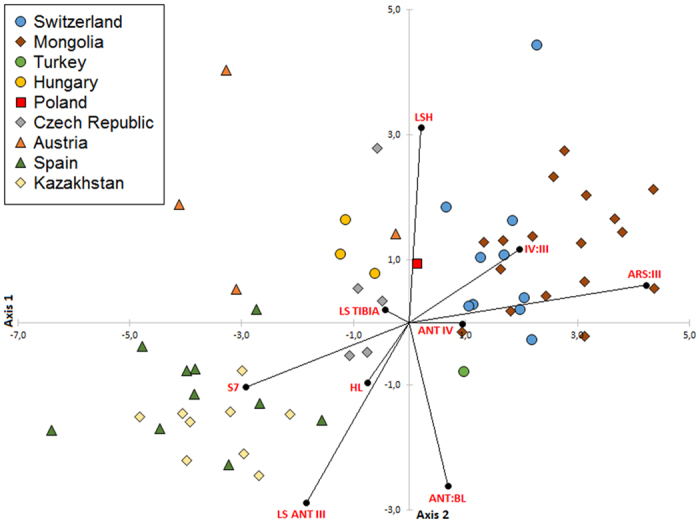
Canonical analysis of specimens of Chaetosiphella stipae stipae (individuals divided according to the place of occurrence) with the appointment of the impact of 9 morphometric variables and ratios; specimens projected onto the first and second principal axes.